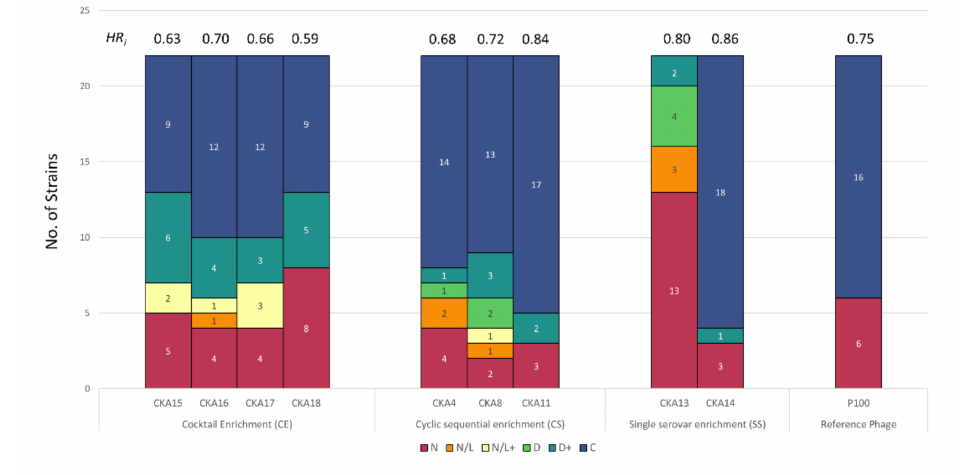
Figure 4. Stacked bar plot showing the host range of Listeria phages isolated using different enrich- ment methods. Designation: C, complete inhibition, D+, >5 h delay to reach exponential phase; D, <5 h delay to reach exponential phase; N, no effect; HR i , host range